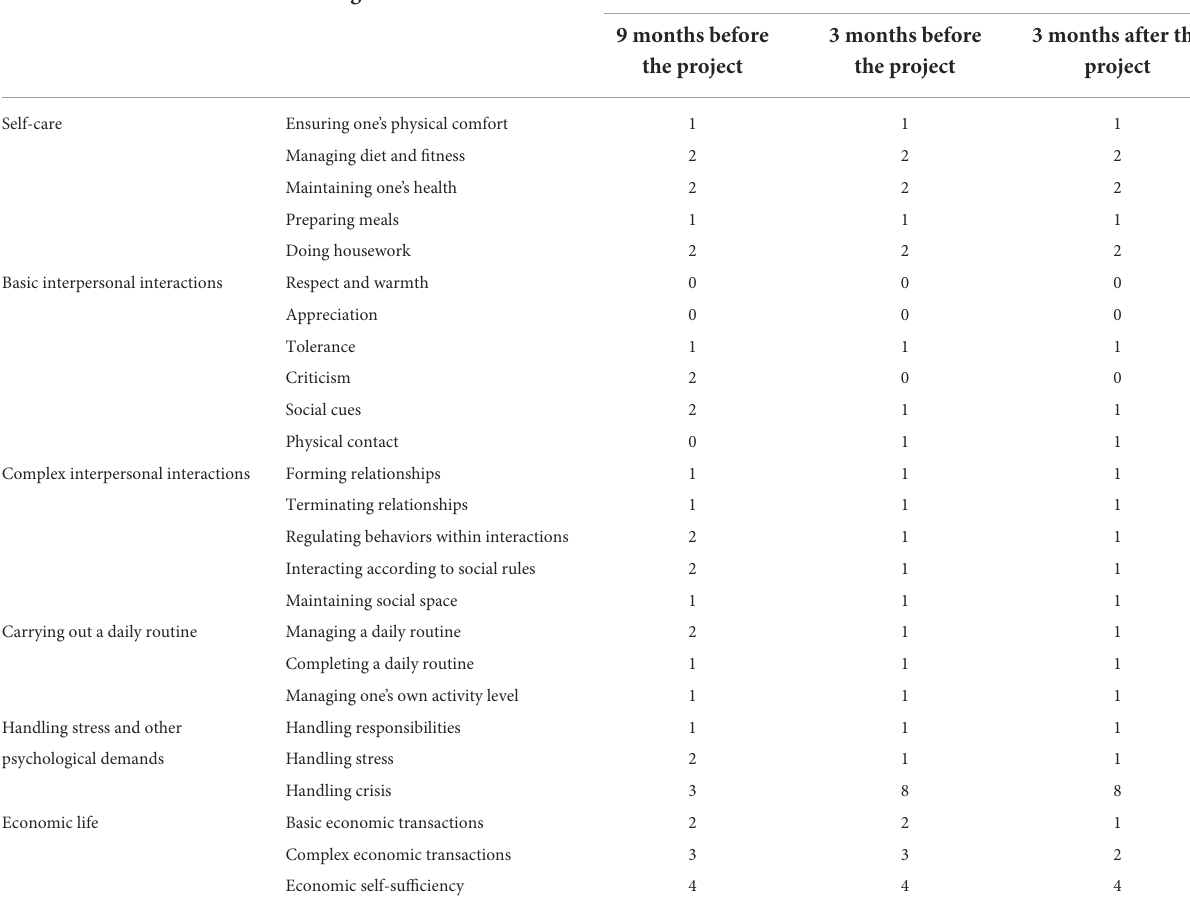
TABLE 1 Change of Scale on the ICF functioning. ICF